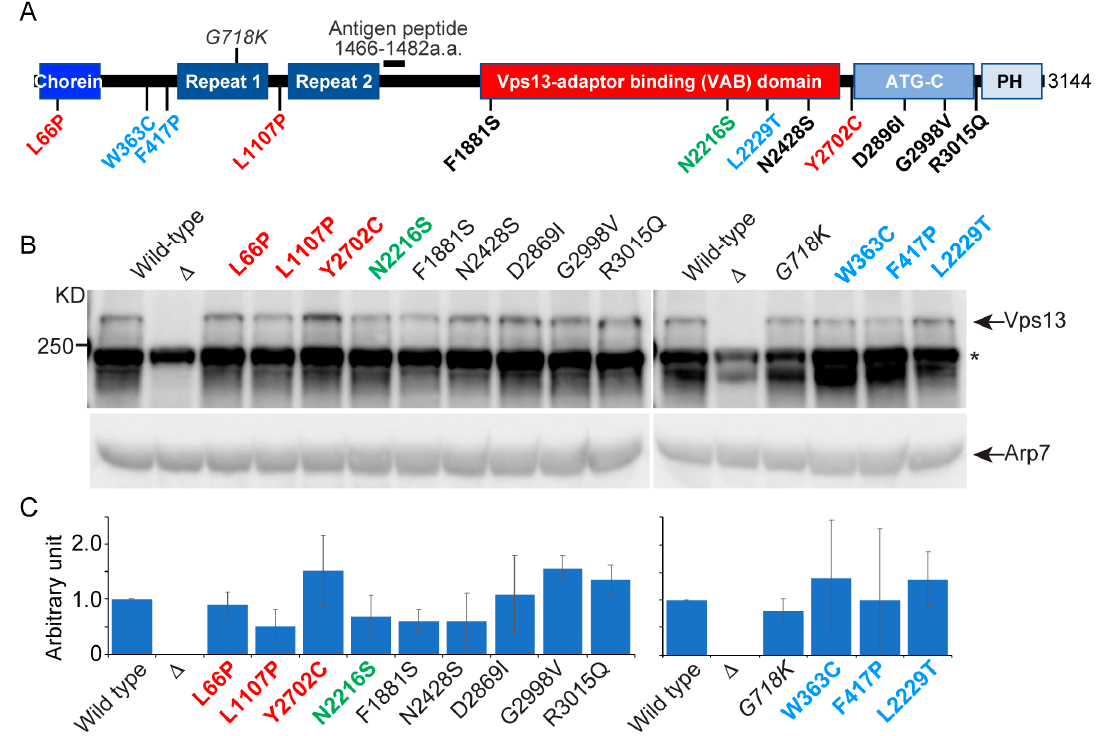
Figure 2. Steady-state levels of yeast Vps13 proteins carrying cognate mutations of various human VPS13 paralogs ( A ) The position of VPS13 cognate mutations with respect to domains of the Vps13 protein. Domains are not drawn to scale. Mutations from the different human VPS13 paralogs are color coded: VPS13A , red; VPS13B, green; VPS13C , blue; VPS13D , black. G718K is a suppressor mutation identified in yeast [13]. The black bar indicates the location of the peptide used to generate the Vps13 antibody (a.a. = amino acid). ( B ) Immunoblot analysis. Protein extracts from the following strains: wild type (BY4741), vps13 ∆ (KO1), vps13-L66P (RP201), vps13-L1107P (RP202), vps13-Y2702C (RP203), vps13-N2216S (JSP770), vps13-F1881S (JSP786), vps13-N2428S (JSP757), vps13-D2869I (JSP787), vps13-G2998V (JSP788), vps13-R3015Q (JSP758), vps13-G718K (JSP549), vps13-W363C (RP206), vps13-F417P (RP207), vps13-L2229T (JSP729) were probed with anti-Vps13 and anti-Arp7 antibodies. The white line indicates two different blots. The asterisk indicates a cross-reacting band. Full blot is shown in Supplementary Figure S1. ( C ) Quantification of Vps13 mutant proteins relative to wild-type Vps13 ([Vps13-X/Arp7]/[Vps13/Arp7]). Graphs show the average of three independent experiments. Error bars indicate one standard deviation.